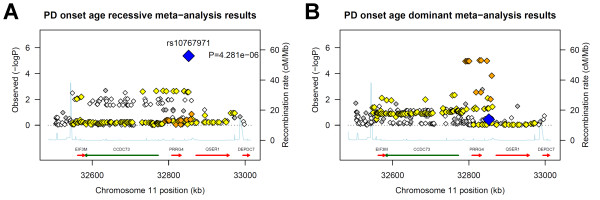
Evidence of association in Chromosome 11 region. Along the x axis is the physical position in the region (in kB) with known genes shown in their orientation The left Y-axis denotes the association test result as -log(p-value) corresponding to diamonds in the figure. The blue diamond identifies the primary SNP result labeled with an rs# and p-value. The color of additional diamonds depicts the pairwise linkage disequilibrium with the primary SNP: red indicates r2 > 0.8, orange 0.5 < r2 < 0.8, yellow 0.2 < r2 < 0.5, white r2 < 0.2, grey unknown LD. R2 values were obtained from the CEPH HapMap data. The right Y-axis indicates the recombination rate, also obtained from CEPH HapMap data, and shown within the figure by the solid light-blue line. A. Recessive model B. Dominant model.